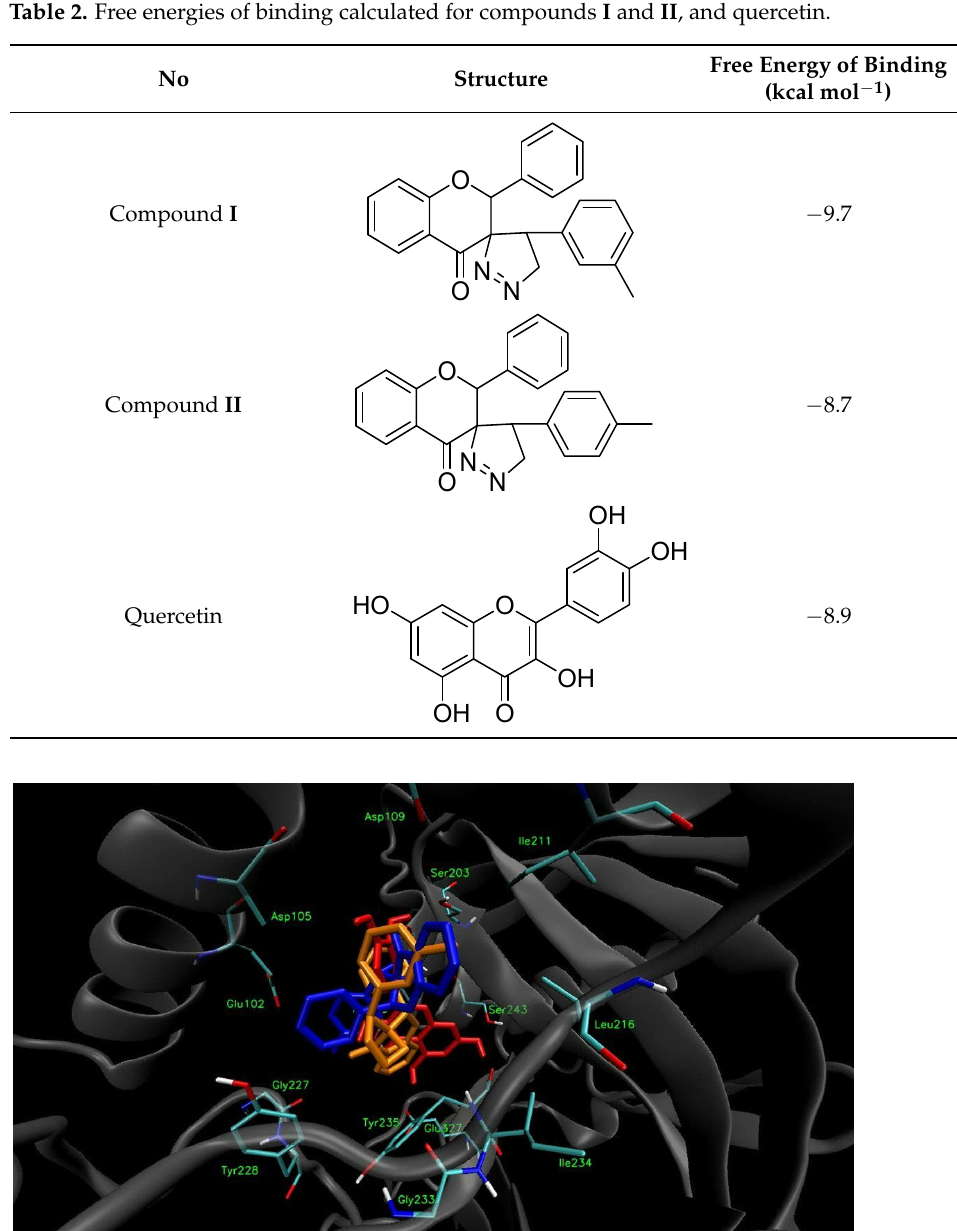
Figure 6. Docked binding modes of compound I (orange) and II (blue), and quercetin (red) to the PARP1 enzyme’s active site.